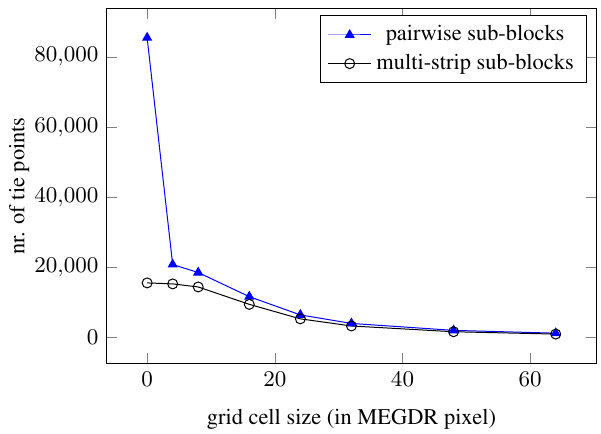
Figure 10: Number of tie points selected by tie point filter